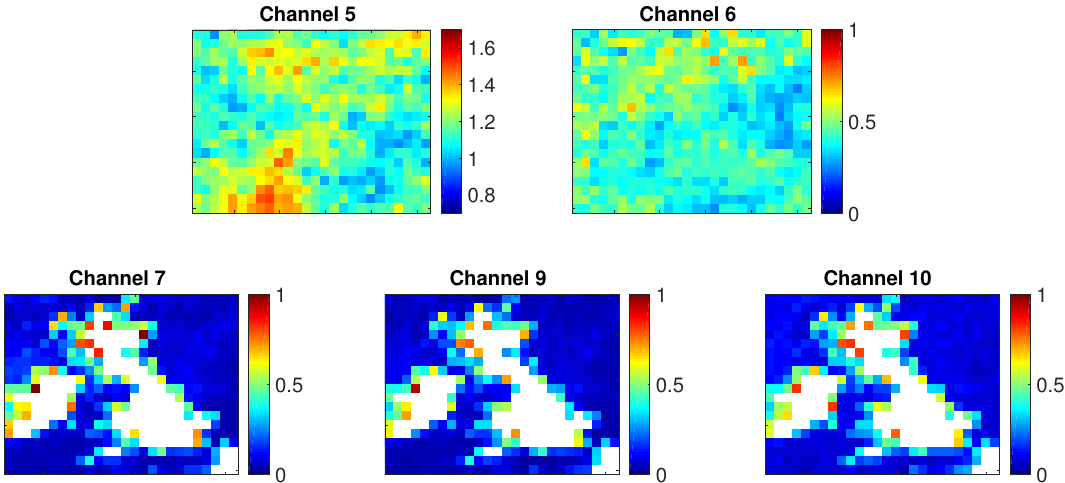
Figure 2. Observation error variance estimated over sub-domains of the UKV for channels 5, 6, 7, 9 and 10. For each sub-plot, each pixel represents the variance calculated over that sub-domain of the full UKV domain. White pixels are areas where there was no data available for calculating the observation error variance. Note that the colour scale is different for Channel